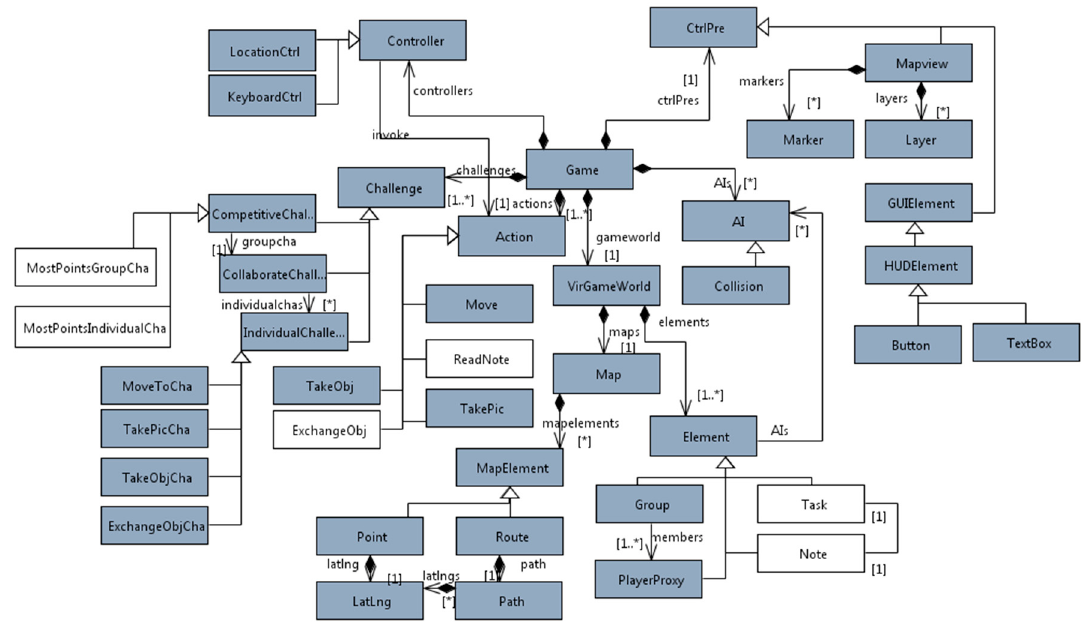
Figure 9. The initial meta-model for the case study.